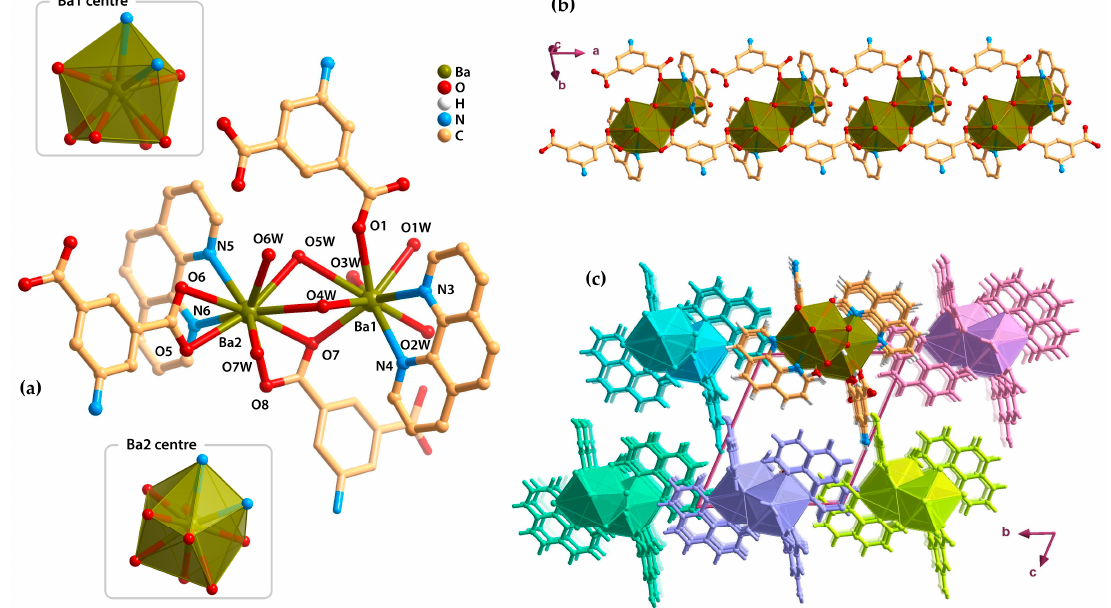
Figure 5. Selected details in the structure of [Ba 2 (aip) 2 (phen) 2 (H 2 O) 7 ] ∙ 2(phen) ∙ 2(H 2 O) ( 5 ): ( a ) partial asu with the labelling scheme for all the atoms of the coordination sphere and the coordination environment of Ba1 and Ba2 centers (also shown as separated polyhedral representation); ( b ) 1D metal–organic chain showing a ladder arrangement and running along the a -axis of the unit cell; ( c ) extended packing arrangement viewed in the [0 1 1] direction of the unit cell (the 1D coordination chains are drawn at different colors).